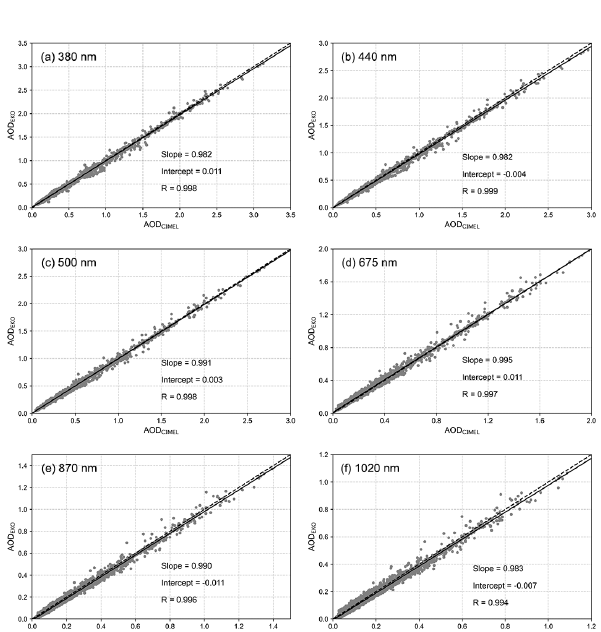
Figure 13. Comparison of AOD EKO versus AOD CIMEL at 380nm (a) , 440nm (b) , 500nm (c) , 675nm (d) , 870nm (e) , and 1020nm (f) from June 2020 to March2021 at the IAP.